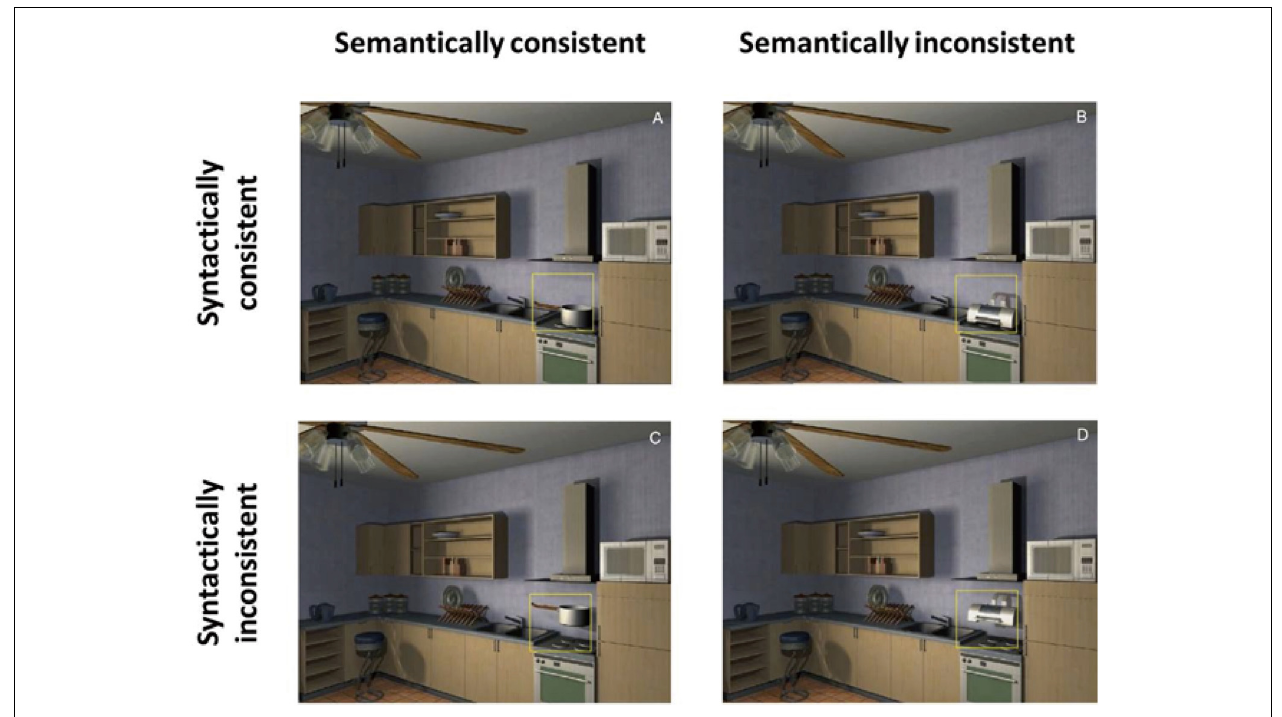
FIGURE 4 | Examples of semantic and syntactic relations in a kitchen scene. (A) Semantically and syntacticallyconsistent. (B) Semantically inconsistent (the printer does not belong in the kitchen scene) but